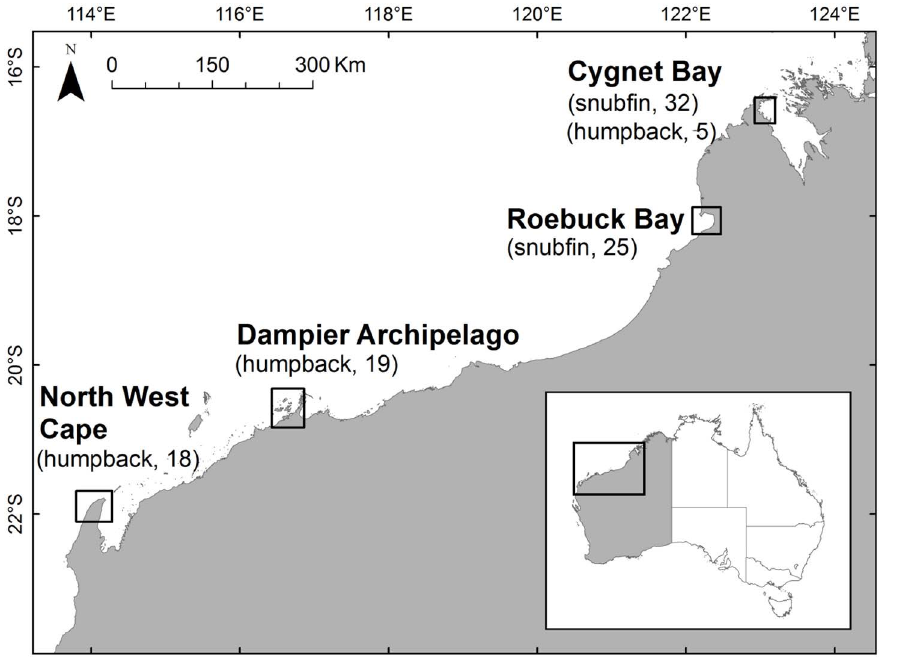
Figure 1. Biopsy sampling locations and sample sizes of Australian snubfin and Indo-Pacific humpback dolphins in north-western Australia.